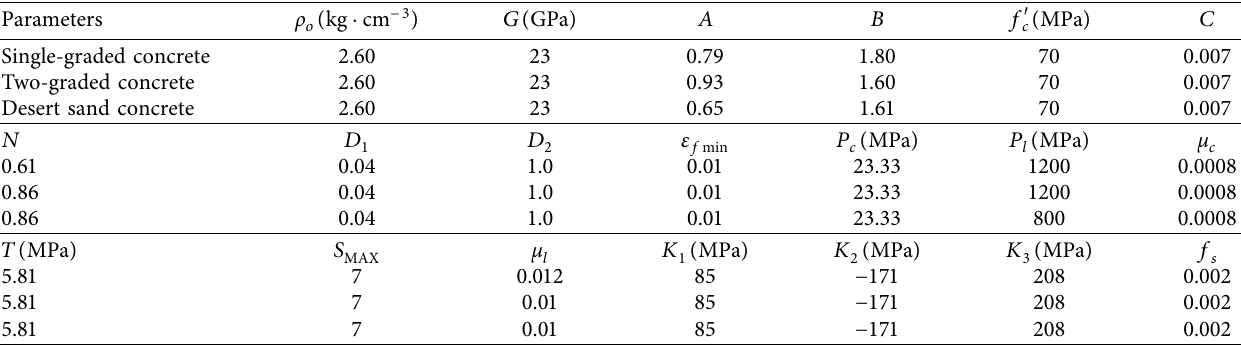
Table 6: Model parameters for coarse